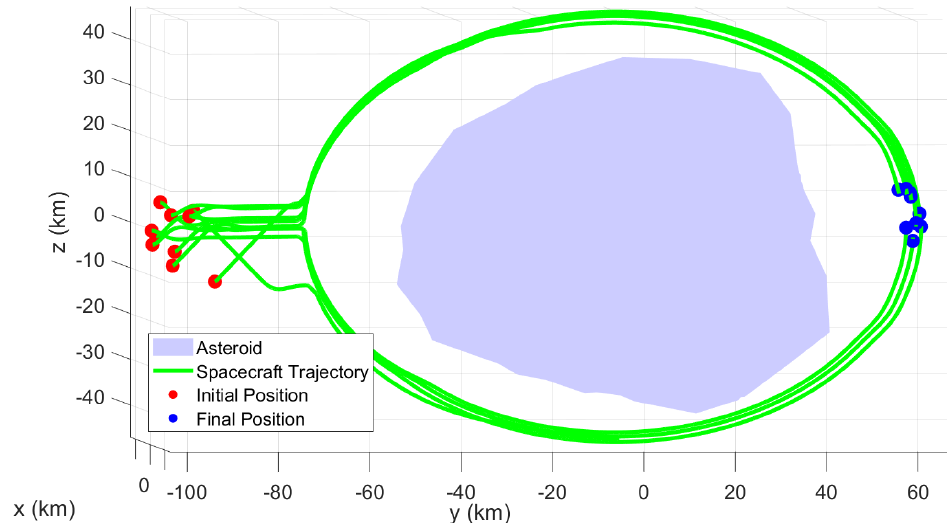
Figure 17. Spacecraft trajectories with varying initial and final conditions.